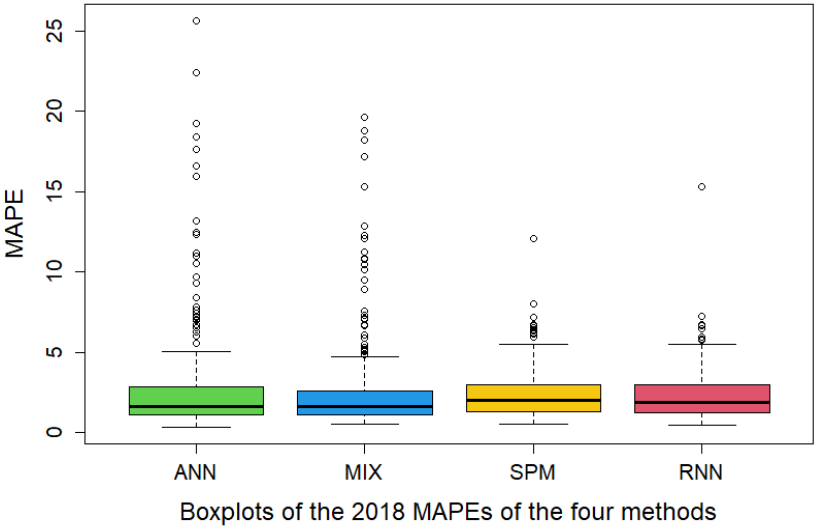
Figure 8. Performance Comparisons of the Daily MAPEs for ( D + 1)-day Forecasts with the ANN, Mixed, Semi-Parametric and RNN Models.